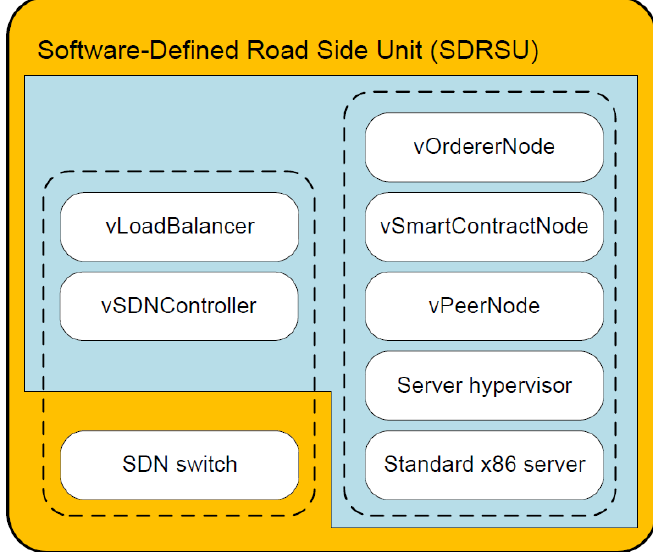
Figure 3. The architecture of Software-Defined Road Side Unit